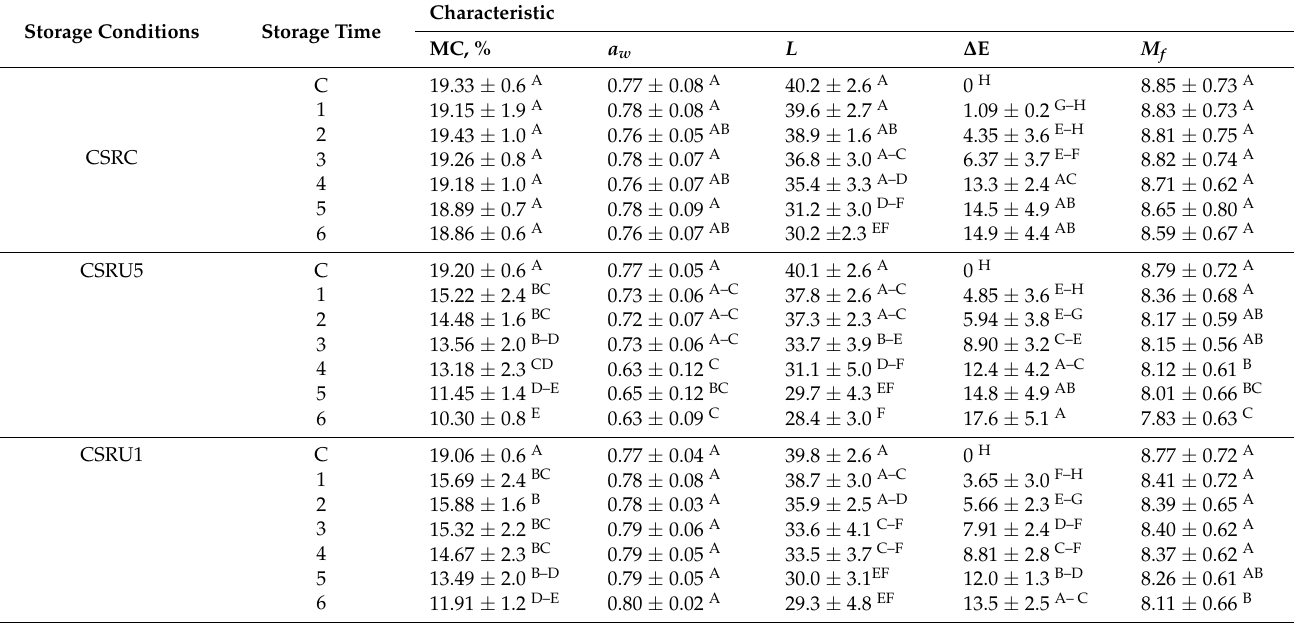
CSRC is the cold storage room with controlled RH at 80% and temperature of 5 ◦ C, CSRU5 is the traditional cold storage room with a temperature of 5 ◦ C, CSRU1 is the traditional cold storage room with a temperature of 1 ◦ C. The same letter in each column of the measured characteristic indicates no significant differences at the 0.05 level (Tukey